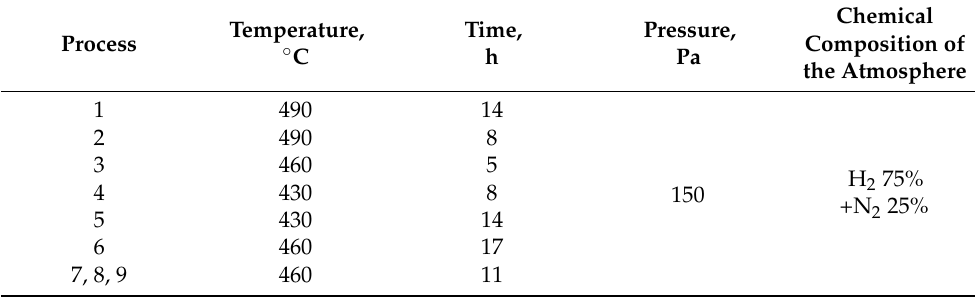
Table 2. Conditions for the nitriding process of austenitic 316L steel.